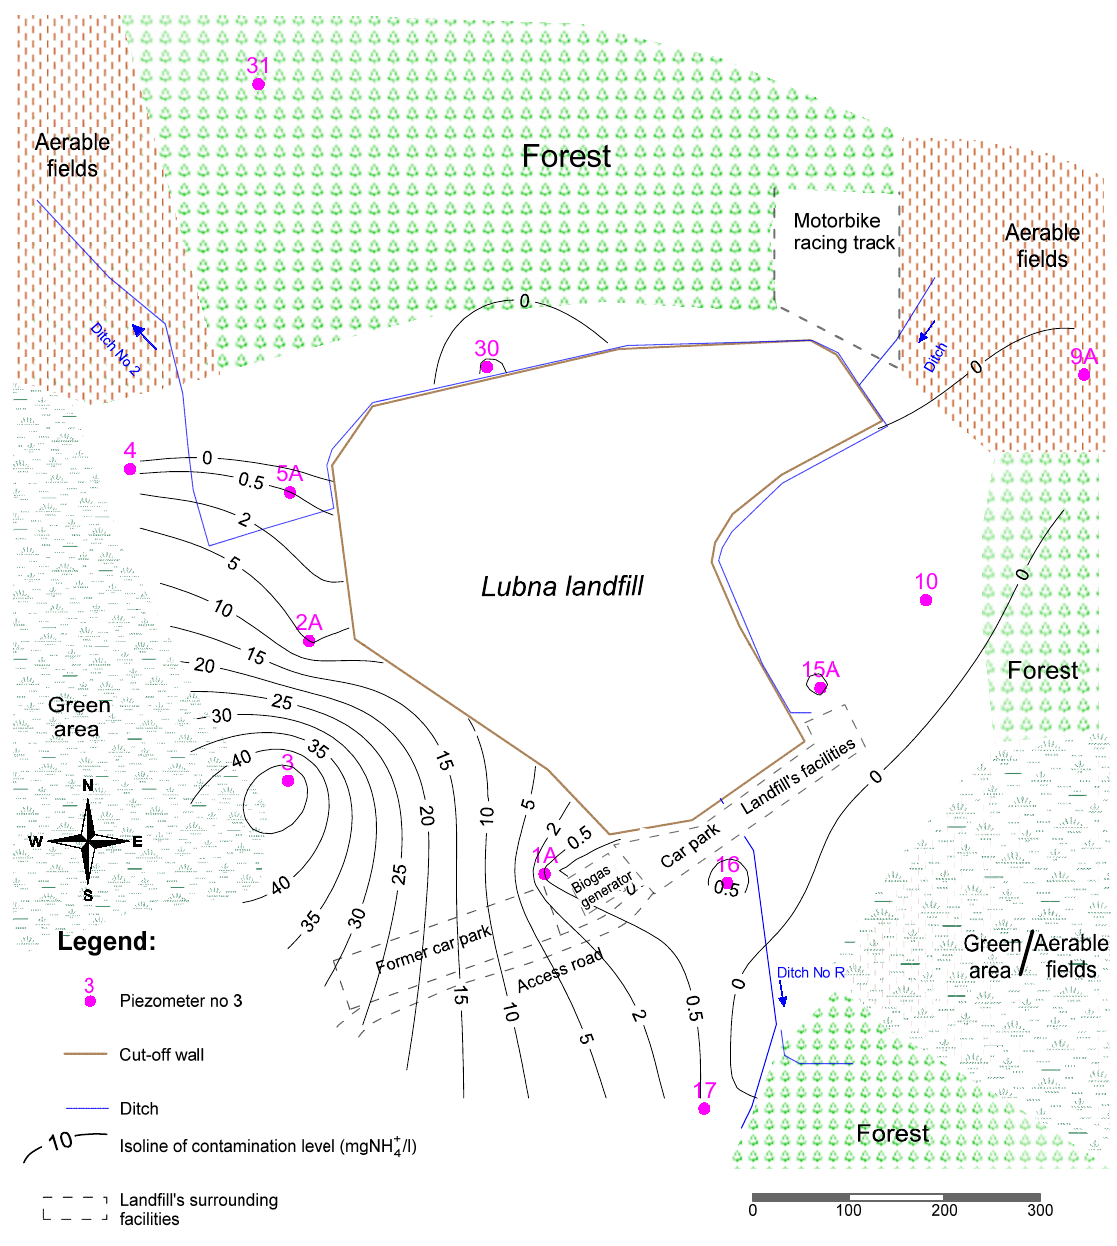
Figure 5. Ammonium nitrogen migration covers the path of groundwater flow within the area of the landfill; however, it is limited by the processes of sorption (Figures 9 and 10).